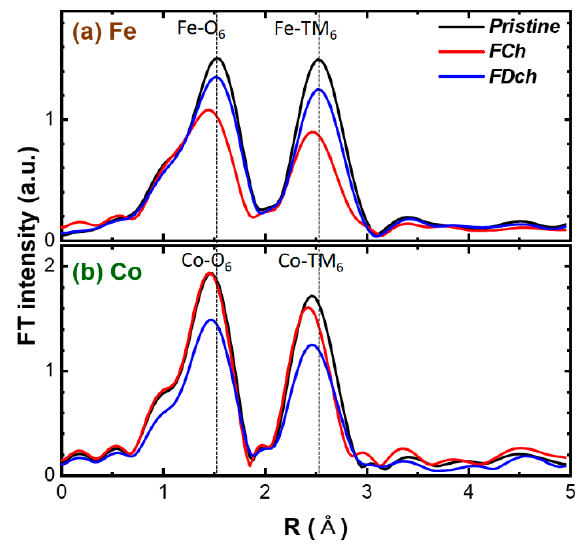
Figure 5. Ex situ EXAFS spectra at ( a ) Fe and ( b ) Co K-edges of NFCTO electrode at pristine, fully charged (4.0V) and fully discharged (2.0V) sates.